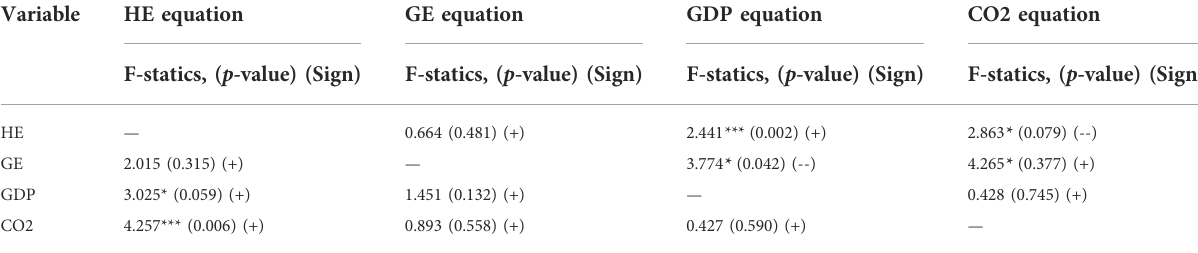
TABLE 6 Granger-Causality Analysis based on Bootstrap ARDL Model.